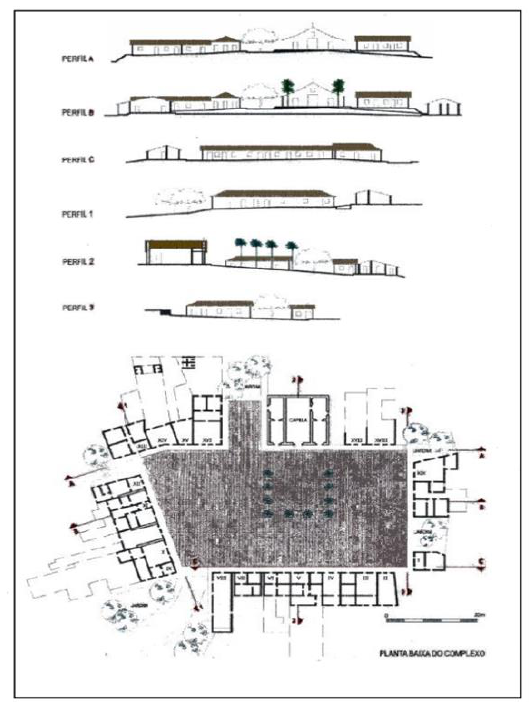
Figure 7. Floor Plan of the Carapicuíba Complex. Source: Lemos et al., 2008, p. 95.